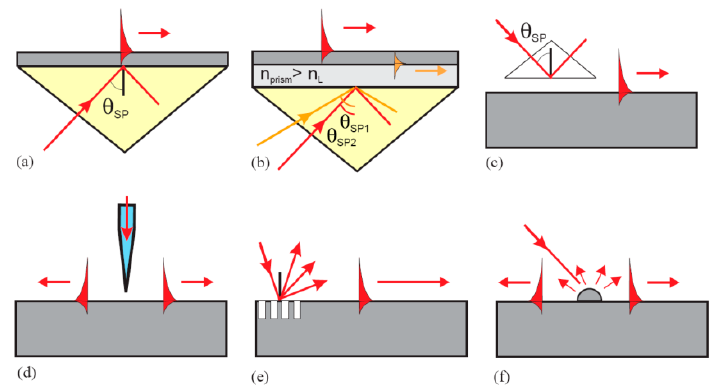
Figure 3. Typical configurations for SPPs excitation. ( a ) Kretschmann prism geometry, ( b ) Two-layer Kretschmann prism geometry; ( c ) Otto prism geometry; ( d ) Excitation with an SNOM probe; ( e ) Excitation by a grating, and ( f ) Excitation by surface features. Reproduced from [33]. Copyright © 2004, Elsevier.